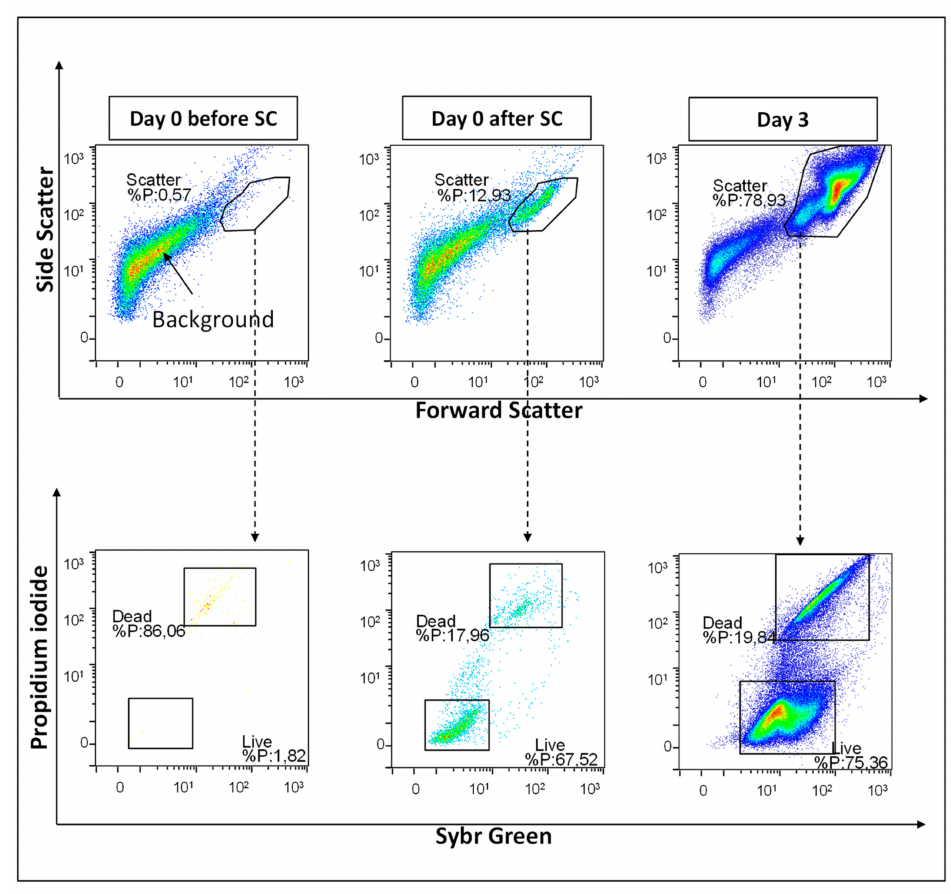
Figure 1. FCM analysis and gating strategy for the SYBR-PI protocol. The different colours indicate the cell density (blue/green = low cell density; yellow/red = high cell density). Before SC: must before SC inoculation; after SC: must after SC